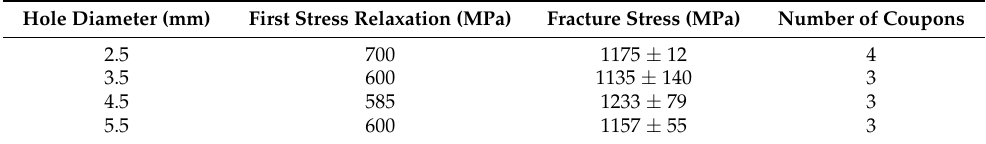
Table 6. Mechanical properties of holed coupons in the compression mode of